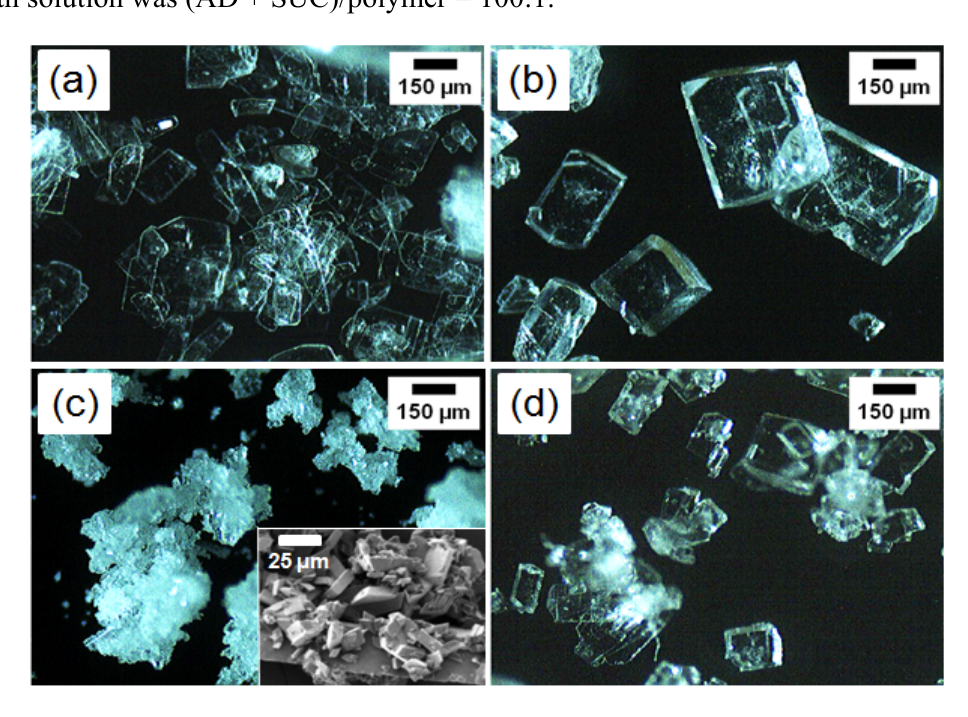
Figure 3. Optical microscopy (OM) and SEM micrographs of AD/SUC